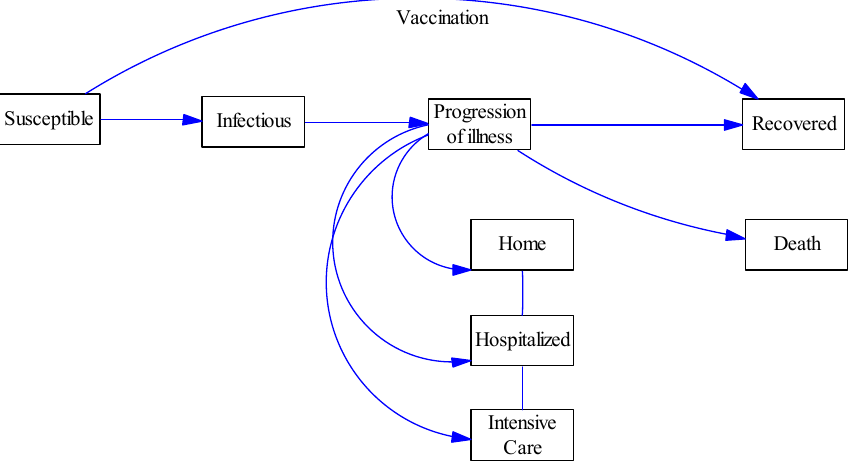
Figure 1. Schematic view of the used compartmental model.